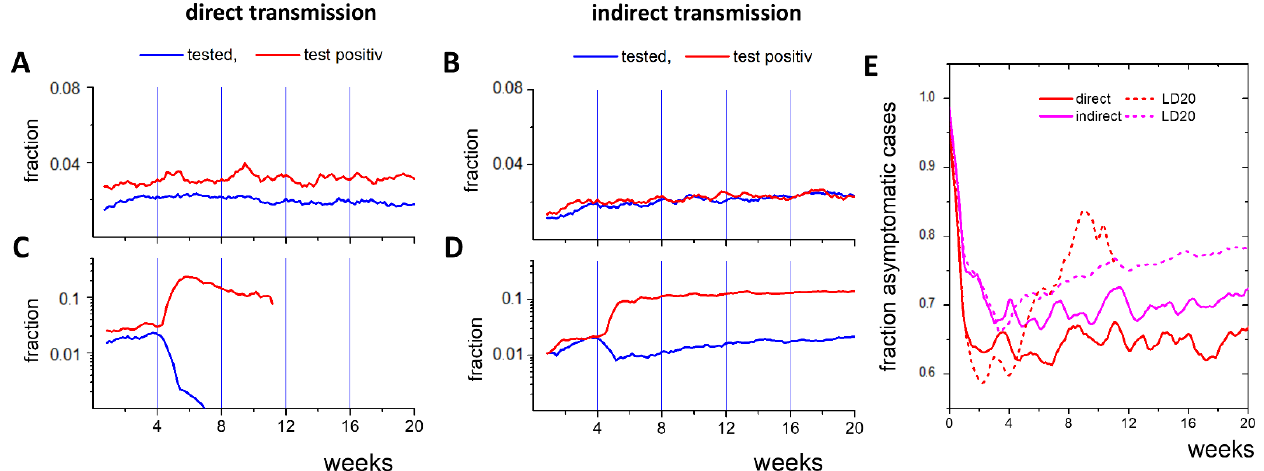
Figure 4. CT properties for direct and indirect transmission. ( A , B ) Fraction of agents tested per day and fraction of the positive tests. ( C , D ) LD20 at t = 4 weeks results in a strong increase of the test positive fraction. The fraction of tested agents falls below 0.001 two weeks after the lockdown start. ( E ) CT affects the fraction of asymptomatic cases among the undetected cases. Under LD20, this fraction increases. Results are averages over 10 simulations and 7 days.